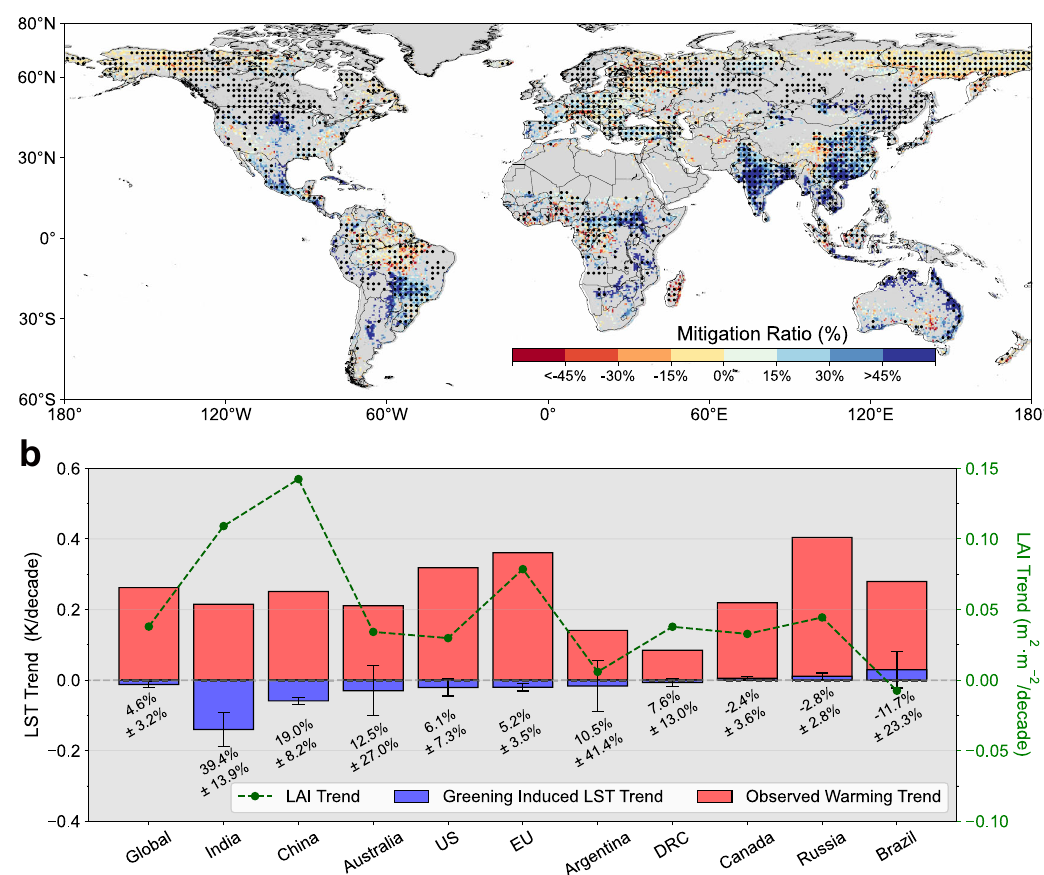
Fig. 6 | Potential mitigation effect of biophysical impact of earth greening. a Spatial map ofmitigation ratio. Only pixels that are signi fi cant at95% con fi dence interval are shown. Areas with statistically signi fi cant greening trends are masked by black dots (Mann – Kendall test, P <0.05). b Comparison of observed tempera- ture trends and greening-induced land surface temperature trends in 10 sizeable